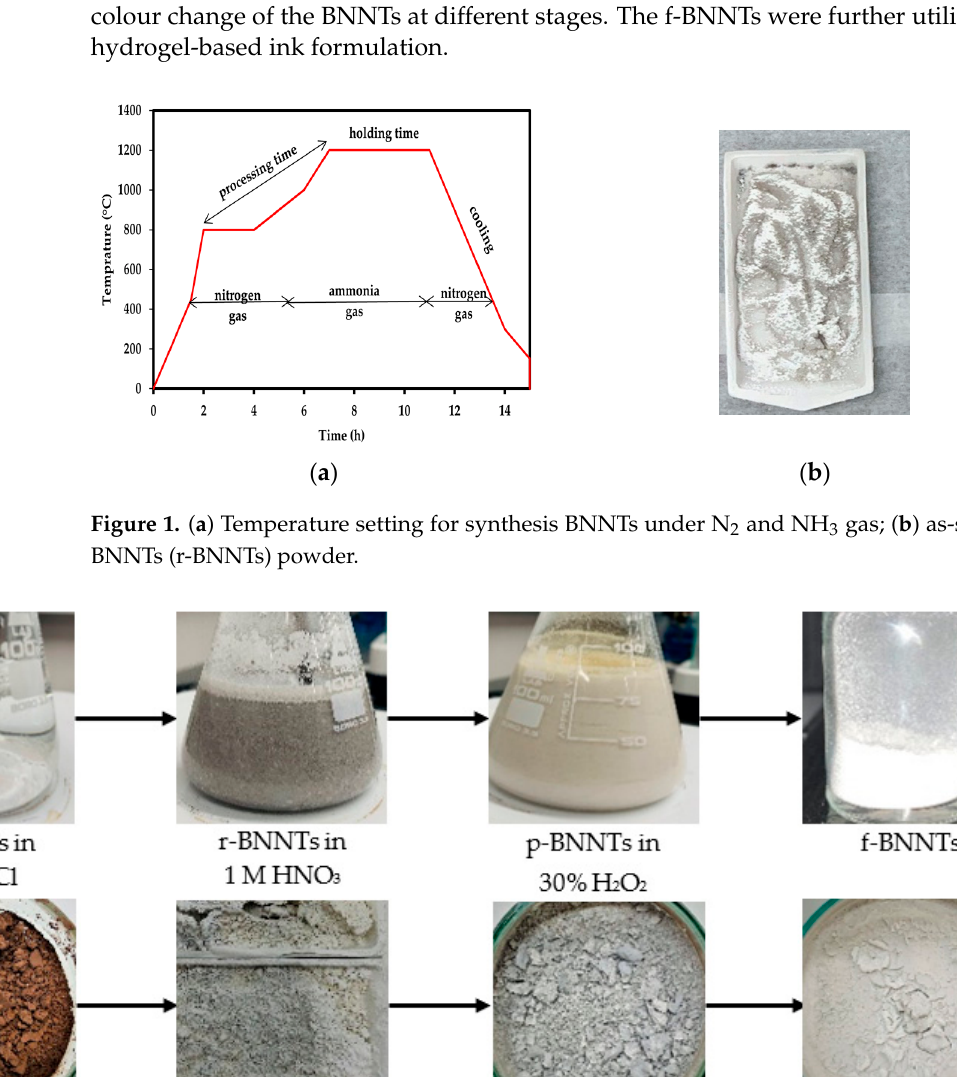
Figure 1. ( a ) Temperature setting for synthesis BNNTs under N 2 and NH 3 gas; ( b ) as-synthesised BNNTs (r-BNNTs) powder.